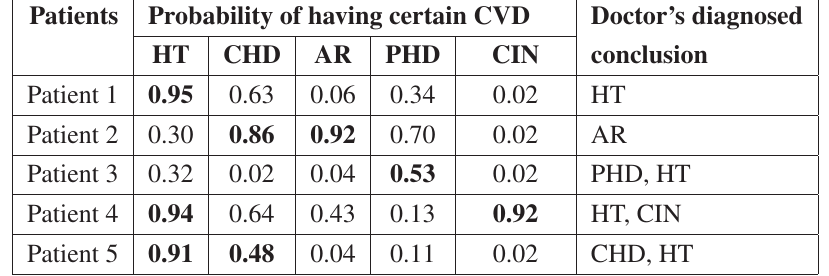
Table 5. Diagnostic results of